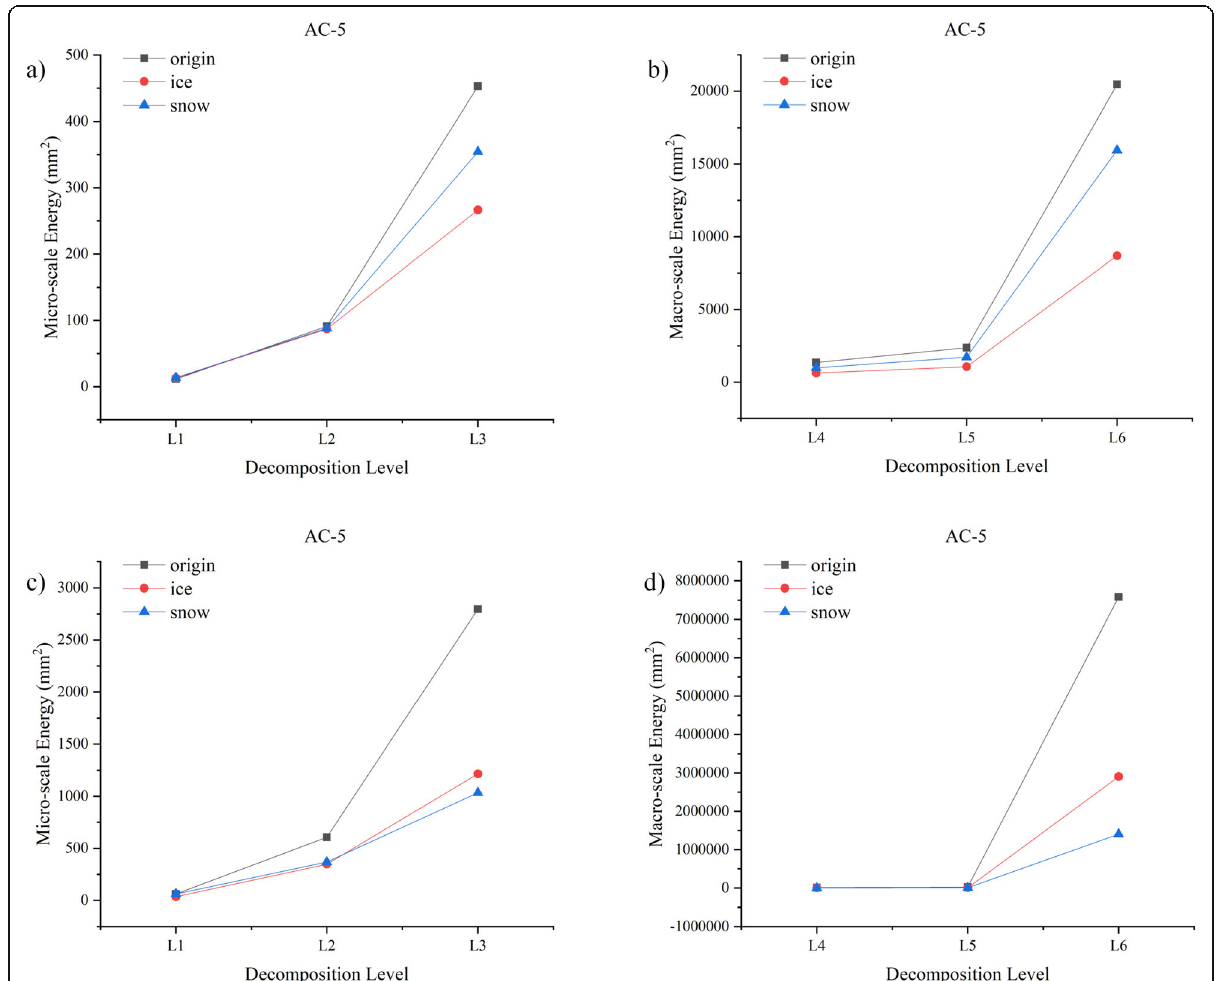
Fig. 7 The Energy Results of AC-5; a 50% Cutting Plane in micro-scale, b 50% Cutting Plane in macro-scale, c 100% Cutting Plane in micro-scale, d 100% Cutting Plane in